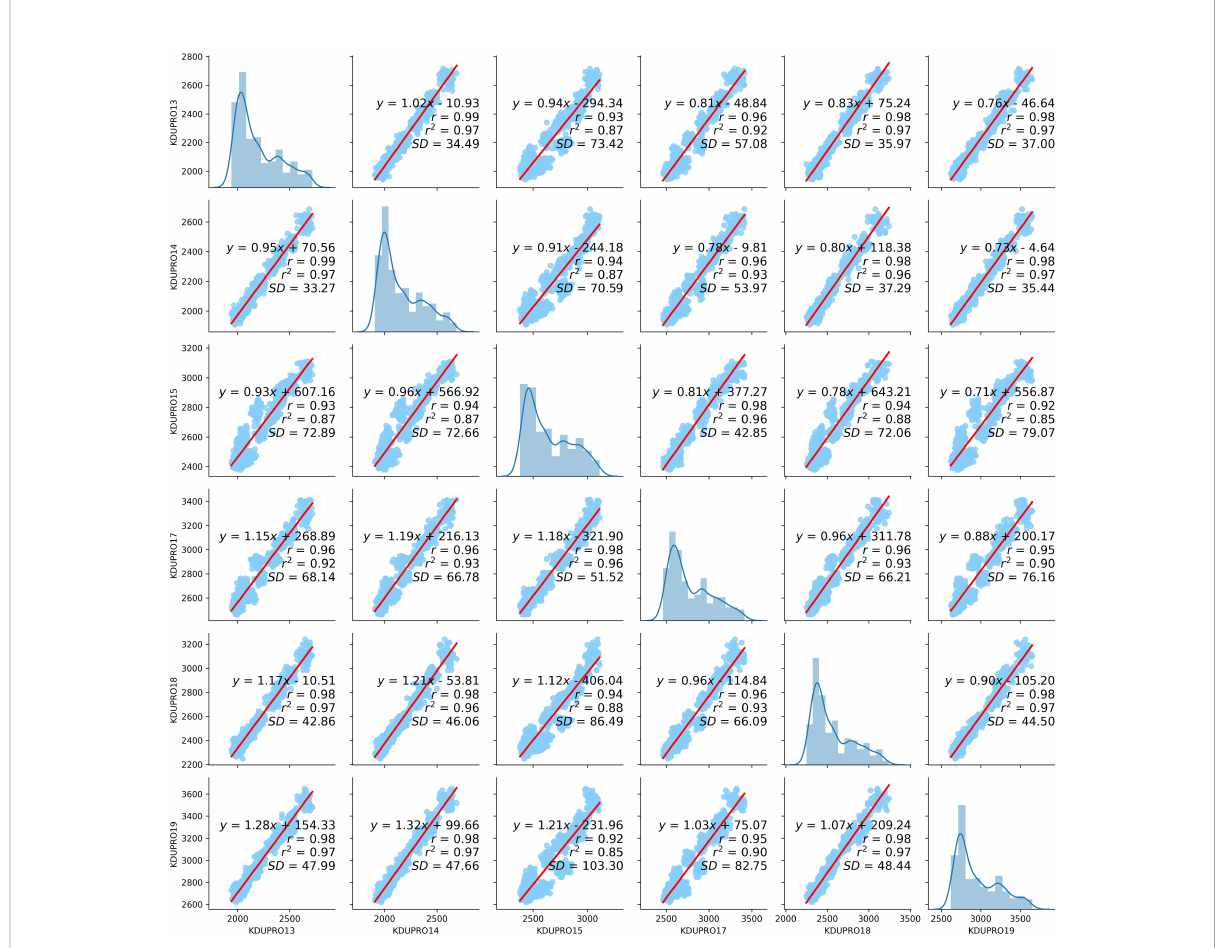
FIGURE 5 Scatter matrix about the relation of the underwater downwelling PAR measurements between all the different modules of the KduPRO, showing the regression line, the correlation coef fi cient, the coef fi cient of determination and the standard deviation from each pair of modules. The data points in the diagonal of the scatter matrix represents a histogram from the time series of the underwater downwelling PAR measurements obtained by each